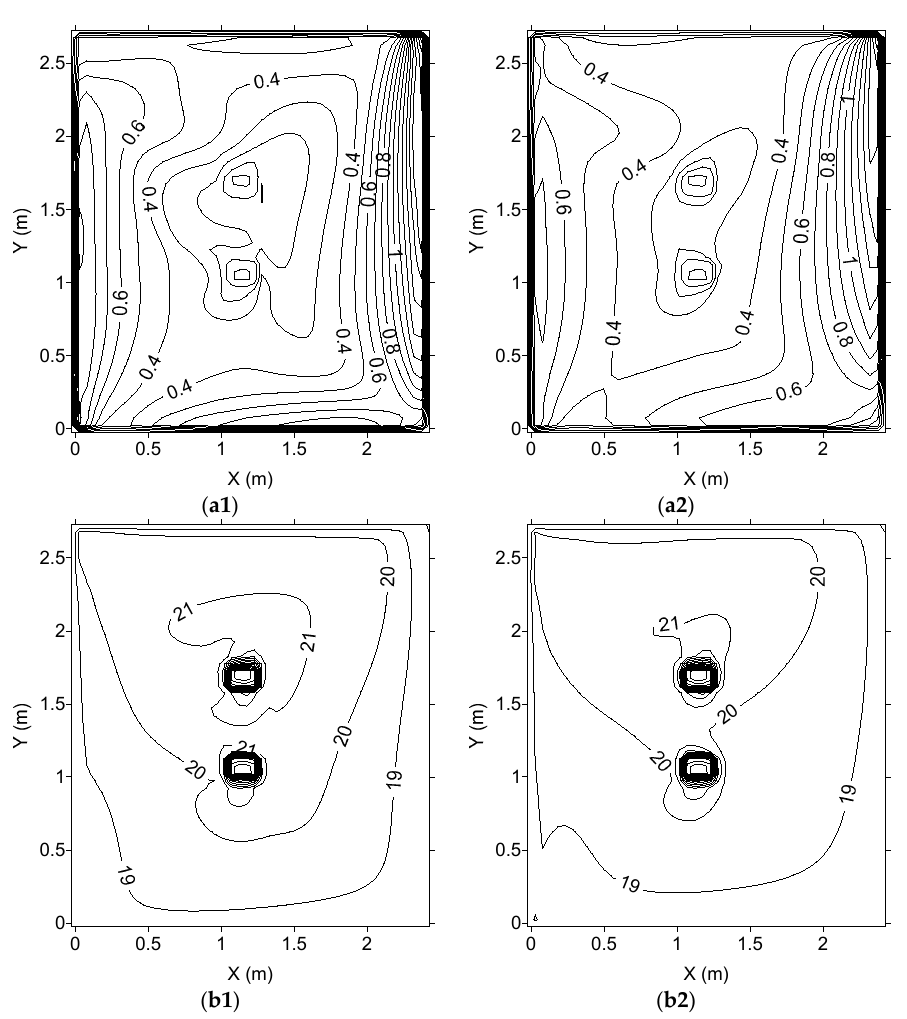
Figure 5. Air velocity ( a1,a2 ) and air temperature ( b1,b2 ) fields in the plan located at Z = 120 cm (Z23), numerically calculated. ( a1,b1 ) are associated with the k-epsilon turbulence model, and ( a2,b2 ) are associated with the RNG turbulence model.